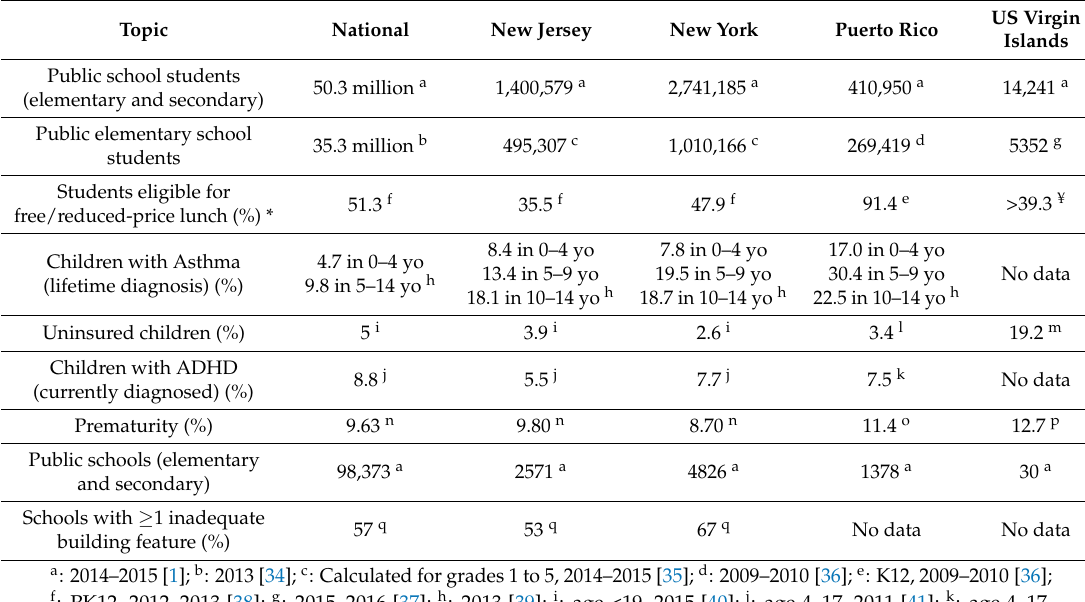
Table 1. US Federal Region 2 area numbers for students and